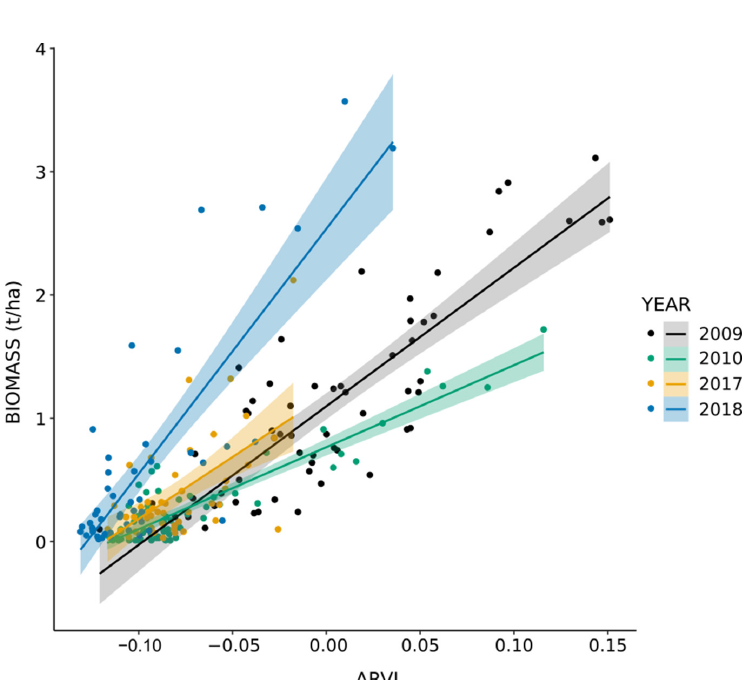
Closer inspection of the linear relationship between biomass and ARVI for the alfa steppe over the years (Figure 7, Figure S6 (for black and white version)) reveals certain disparities between the years, especially concerning the slope of the model (Table 8),